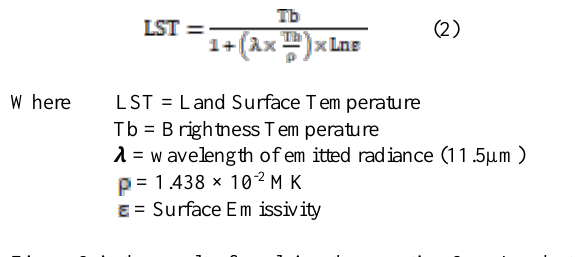
Figure 3 is the result of applying the equation 2 on Landsat-8 image.